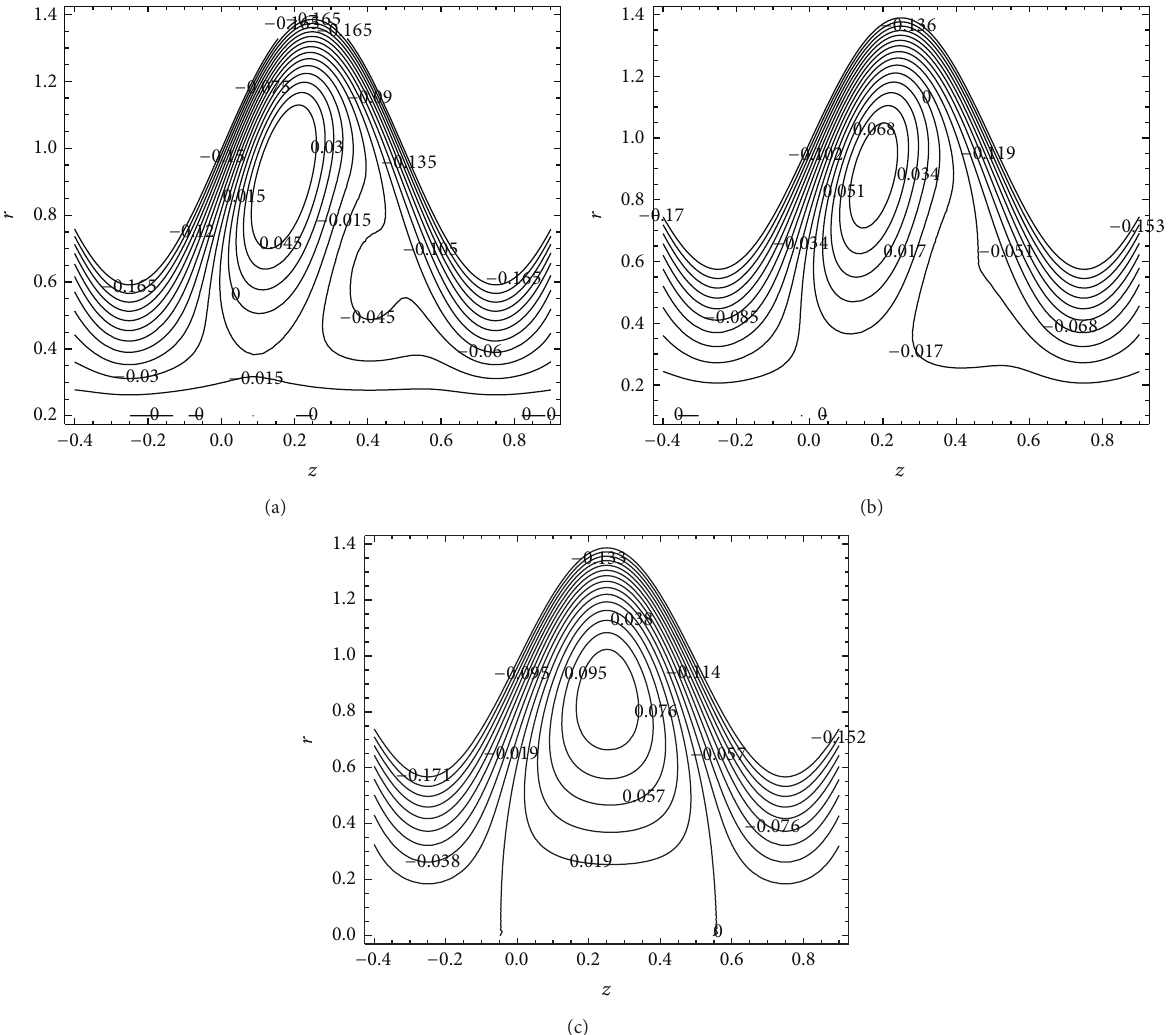
Figure 20: Graph of streamlines for different three values of 𝜖 : (a) 𝜖 = 0.2 , (b) 𝜖 = 0.1 , (c) 𝜖 = 0.0 at 𝛿 = 0.156 , 𝑄 = 0.7 , Wi = 0.05 , Re = 15 , and 𝜙 = 0.4 , 𝑟 ∈ [𝜖,𝑟 2 ]